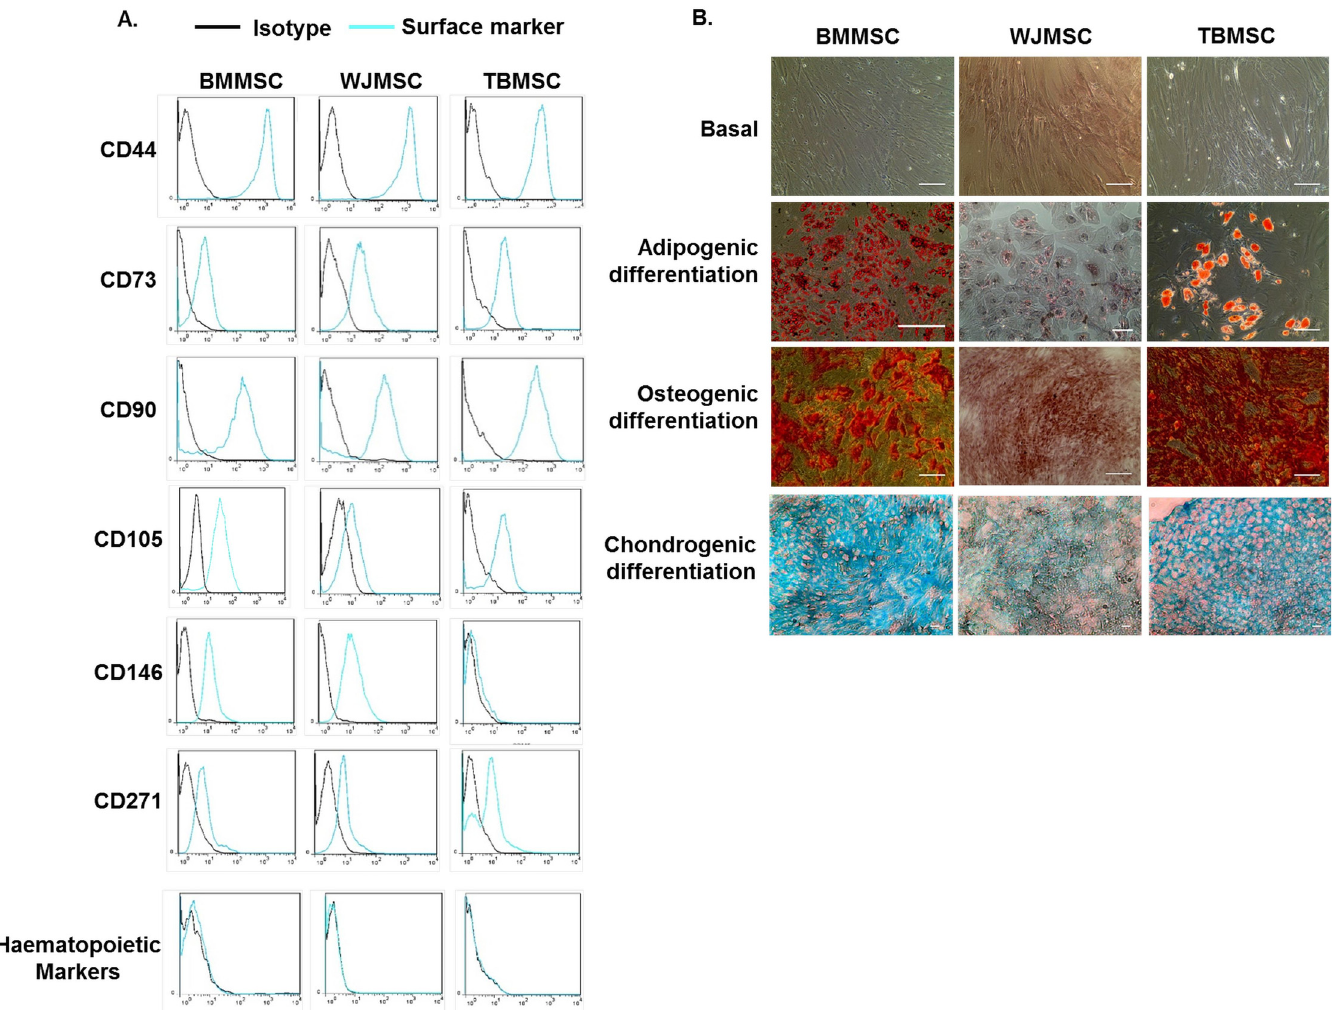
Fig 1. Characterisation of MSC isolated from different tissue sources. (A) Expression of MSC markers CD44, CD73, CD90, CD105, CD146, CD271 and combined expression of the haematopoietic markers CD14, CD20, CD34 and CD45 by BMMSC, WJMSC, or TBMSC by flow cytometry. Data are expressed as representative histograms compared to isotype controls and are representative of n = 3 independent experiments using 3 different MSC donors. (B) BMMSC, WJMSC, and TBMSC were differentiated towards osteoblast, adipocyte, or chrondocyte lineage for 14 or 21 days. Adipogenic, osteogenic and chrondogenic differentiation were assessed using Oil Red O, Alizarin Red or Alcian Blue to stain lipid droplets, calcium deposits or cartilage specific proteoglycans respectively. Phase contrast and colour micrographs are representative of n = 3 independent experiments using 3 different MSC donors. Scale bar represents 10 μ